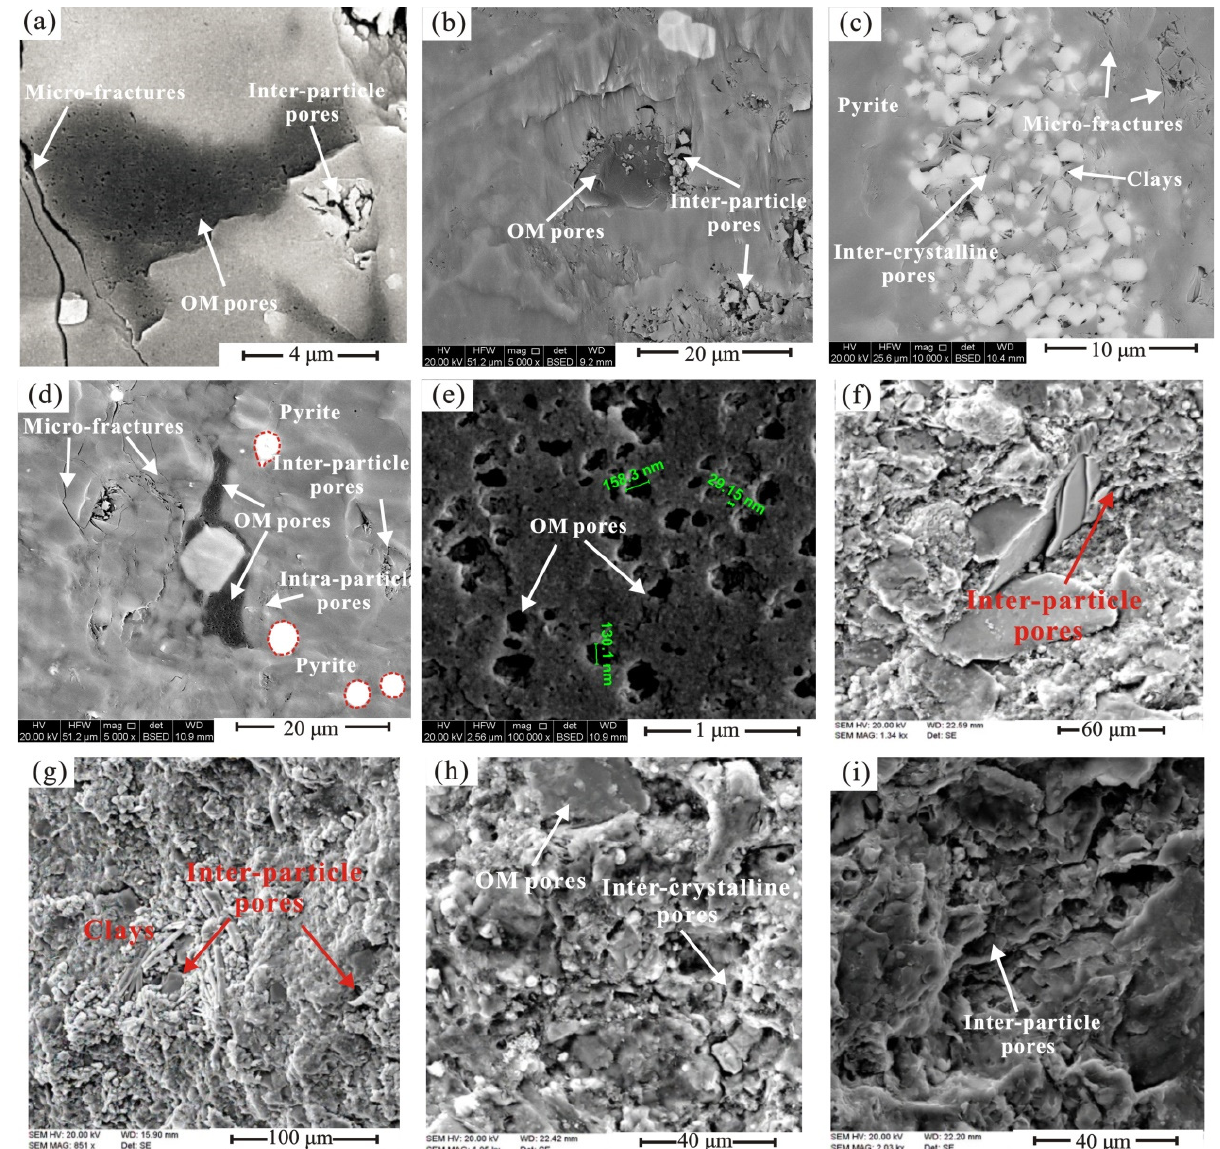
Figure 4. Typical pore types in the FE-SEM ( a – e ) and SEM ( f – i ) images of the Lower Paleozoic shale from the upper Yangtze plate. (( a , b , d – e , h ), OM pores; ( c , d ), IntraP pores; ( a – d , f – i ), InterP pores; ( a , c , d ), micro-fractures).